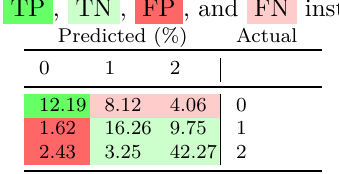
Table 2: Calculation of TP , TN , FP , and FN instances for actual class